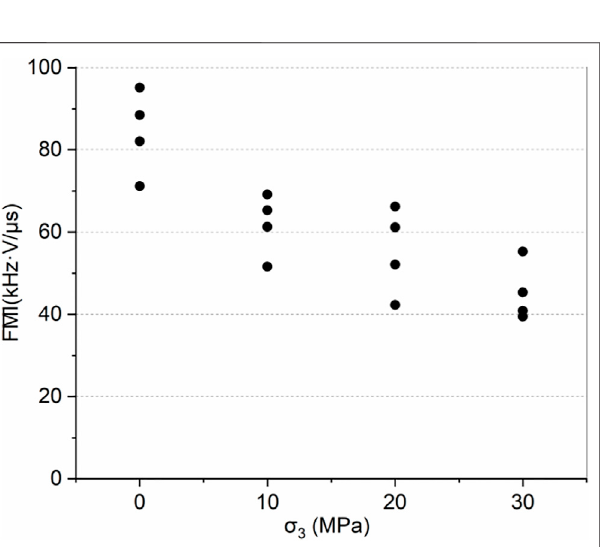
FIGURE 13 | Experimental results of FMI under different con fi ning